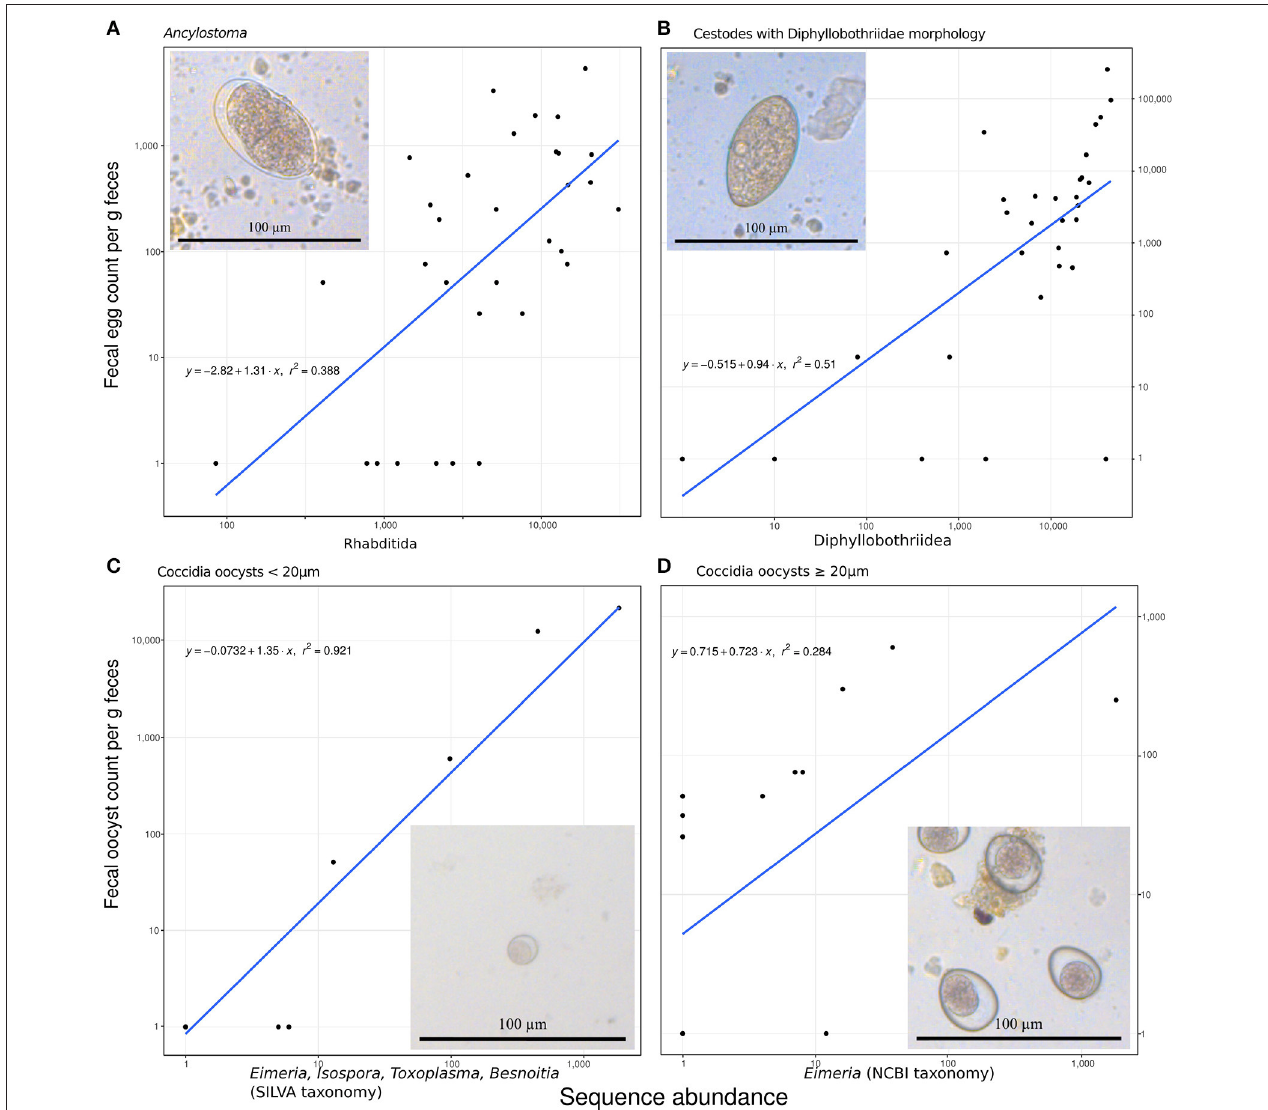
FIGURE 2 | Predicting fecal egg or oocyst counts per g feces from the number of annotated ribosomal sequence variants reads. (A) Ancylostoma FEC vs. sequence counts for the order Rhabditida. (B) Diphyllobothriidae FEC vs. sequence counts for the same family. (C) A small size class of oocyst counts vs. added sequence counts for Eimeria , Isospora , Besnoitia, and Toxoplasma. (D) A large size class of coccidian oocysts vs. Eimeria sequences. All panels contain the formula for the specific linear model on (1 + log 10 ) transformed data, R 2 as a measure of goodness of fit, and a line representing the predicted relationship. The panels additionally include a representative micrograph depicting the egg or oocyst